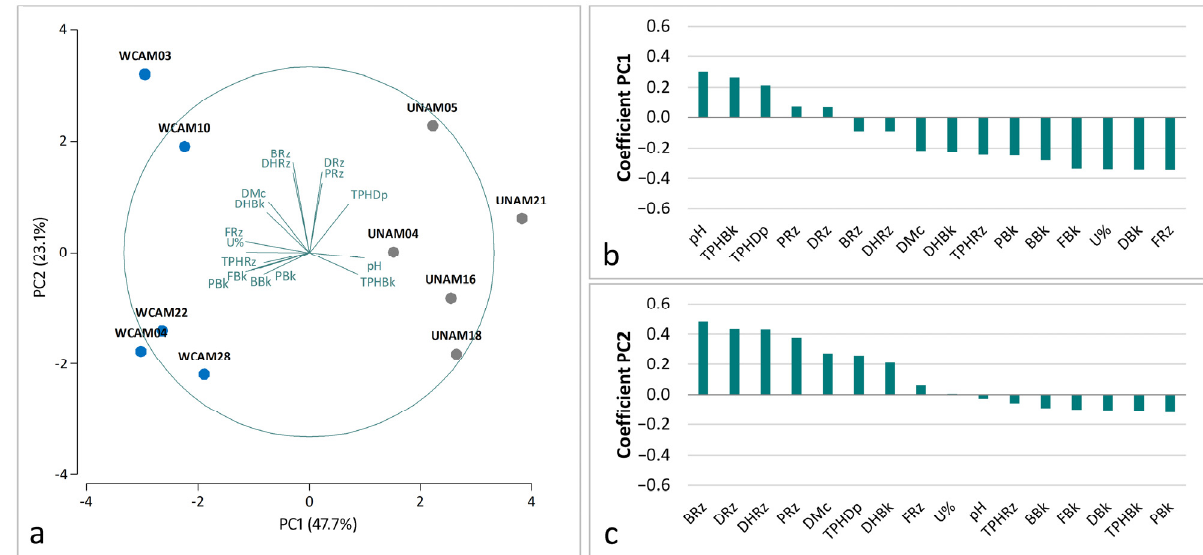
Figure 4. Principal component analysis of the physico–chemical and biological variables measured in the plants and substrates at the end of the phytoremediation test with Helichrysum microphyllum subsp. tyrrhenicum in the refinery substrate with aged contamination unamended (UNAM, grey) and amended with wood chips (WCAM, blue). ( a ) PC1 vs. PC2 plot. The percentage of the variation explained by each axis is indicated in parentheses after the axis label. Coe ffi cients in the linear com- binations of the variables that make up PC1 ( b ) and PC2 ( c ). Variable labels are de fi ned in the text.